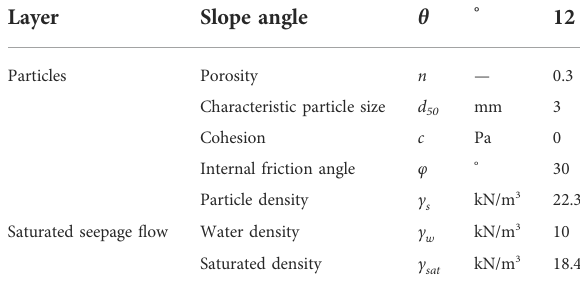
TABLE 1 The parameters of the deposit under saturated seepage fl ow conditions.